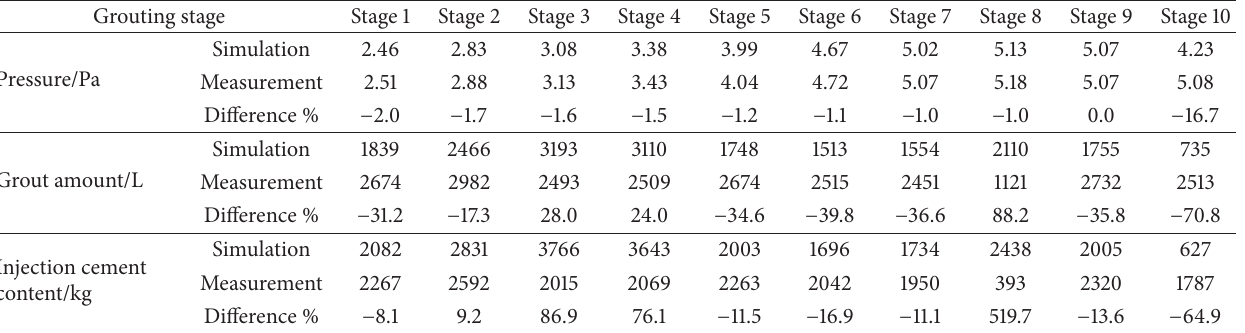
Table 2: Simulation results in each grouting